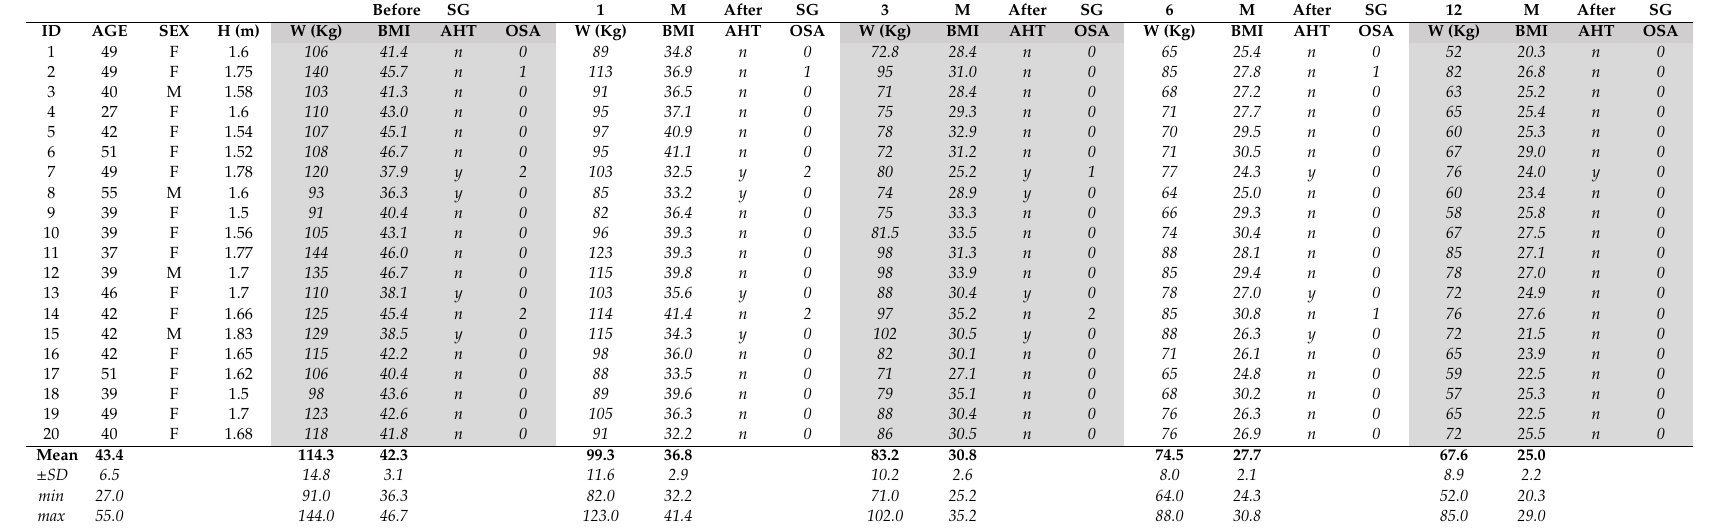
Table 1. Sleeve gastrectomy outcomes and